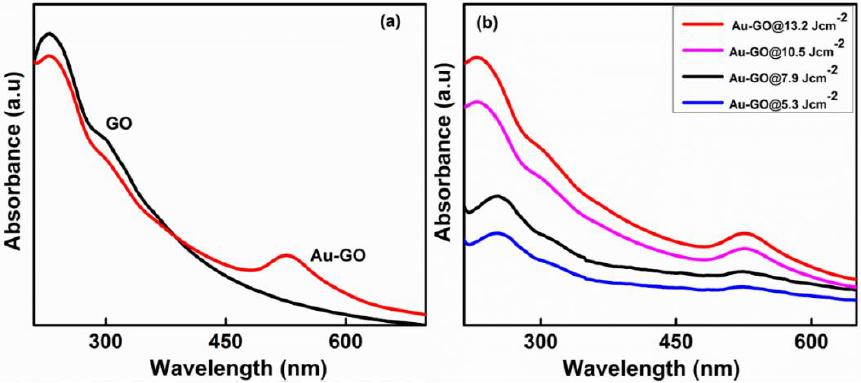
Figure 2. UV-Vis absorption spectrum. ( a ) GO and Au-GO nano-hybrid; ( b ) Au-GO at different laser